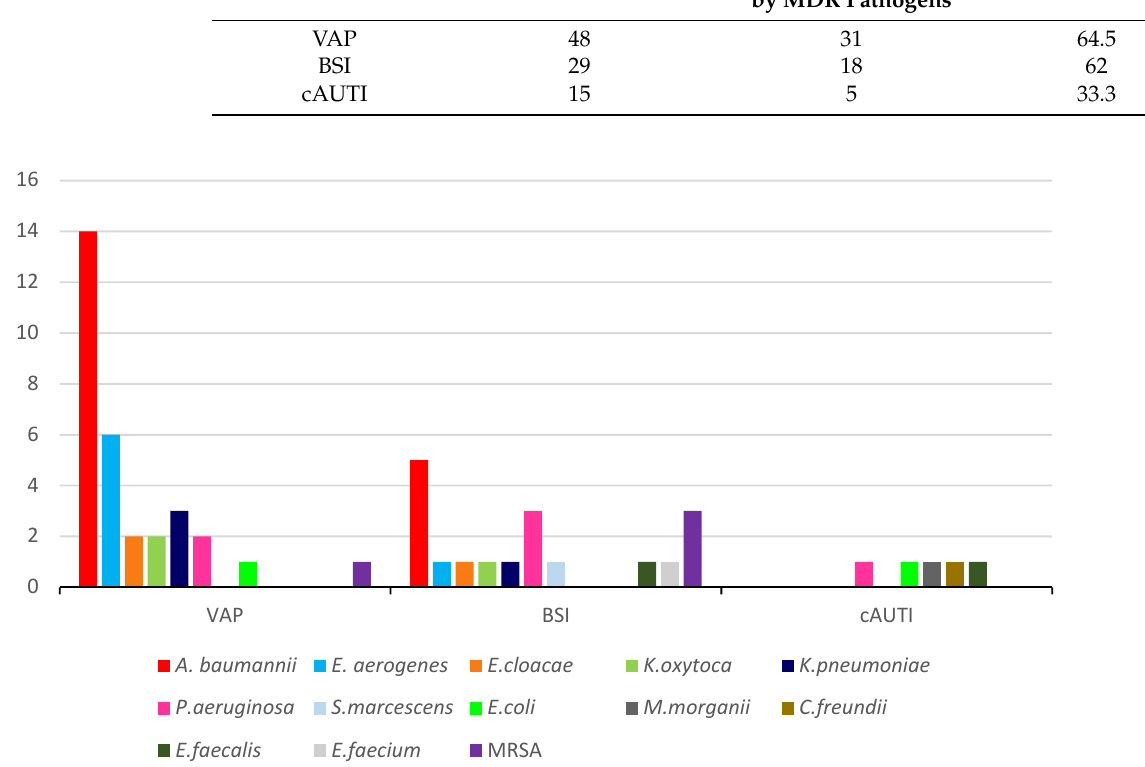
Figure 1. MDR pathogens (n°) causing VAP, BSI and cAUTI. A total of 11 patients (12.3%) were colonized, while in the remaining 10 patients